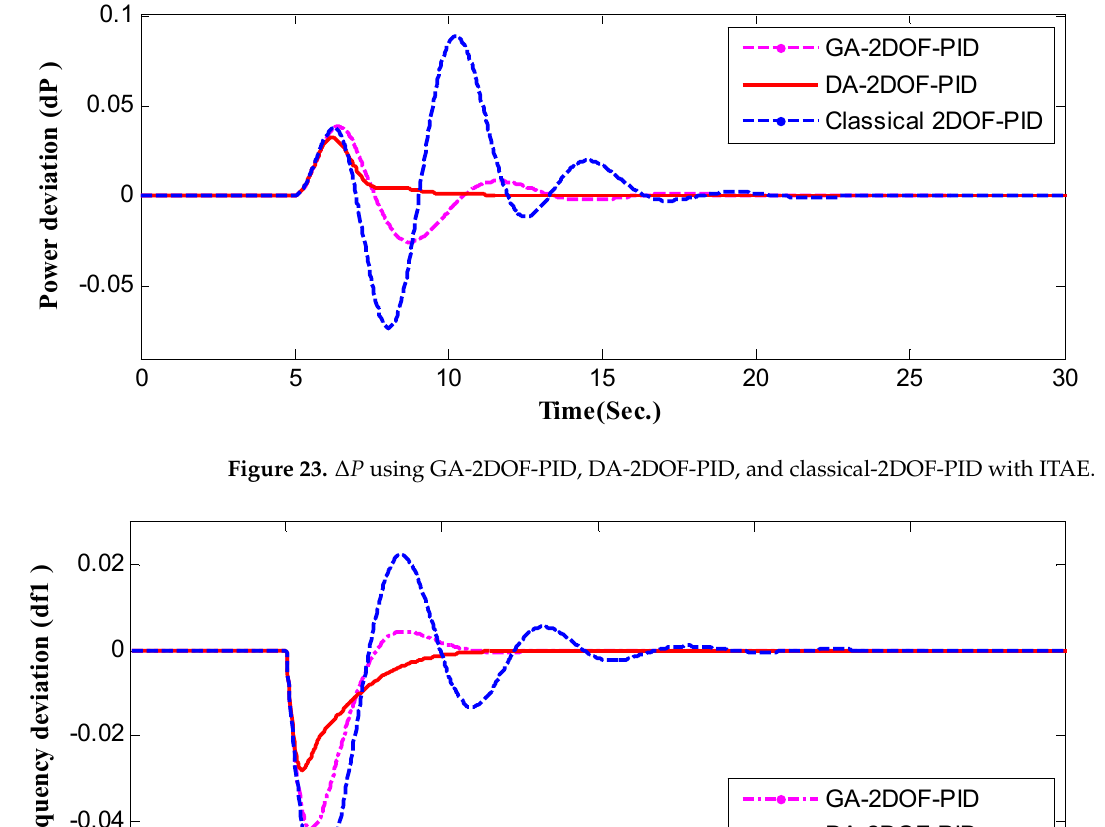
24 of 35 Figure 21. Δf (cid:2869) , using GA-2DOF-PID, DA-2DOF-PID, and classical-2DOF-PID with ITAE.